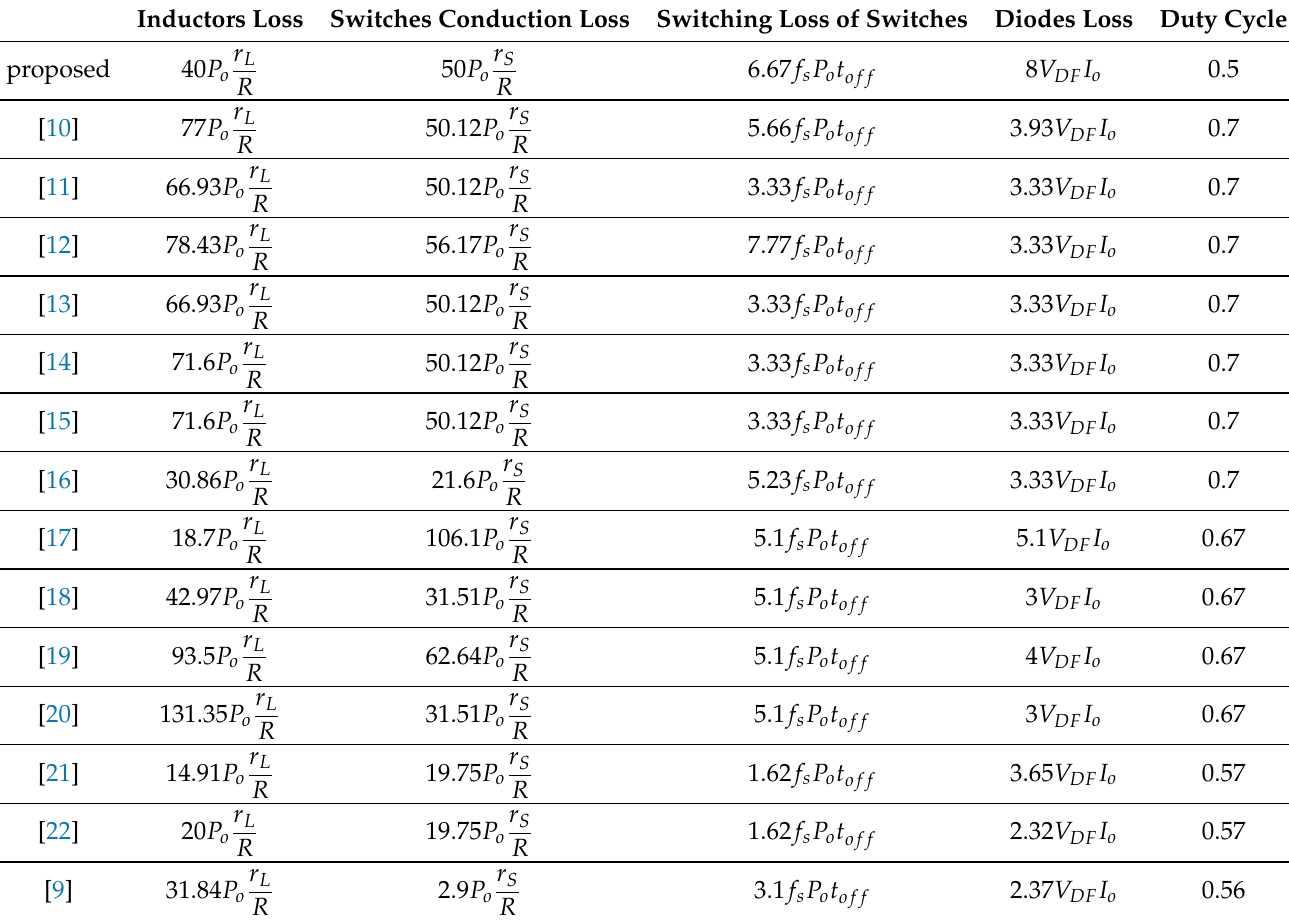
Table 2. Comparison of power